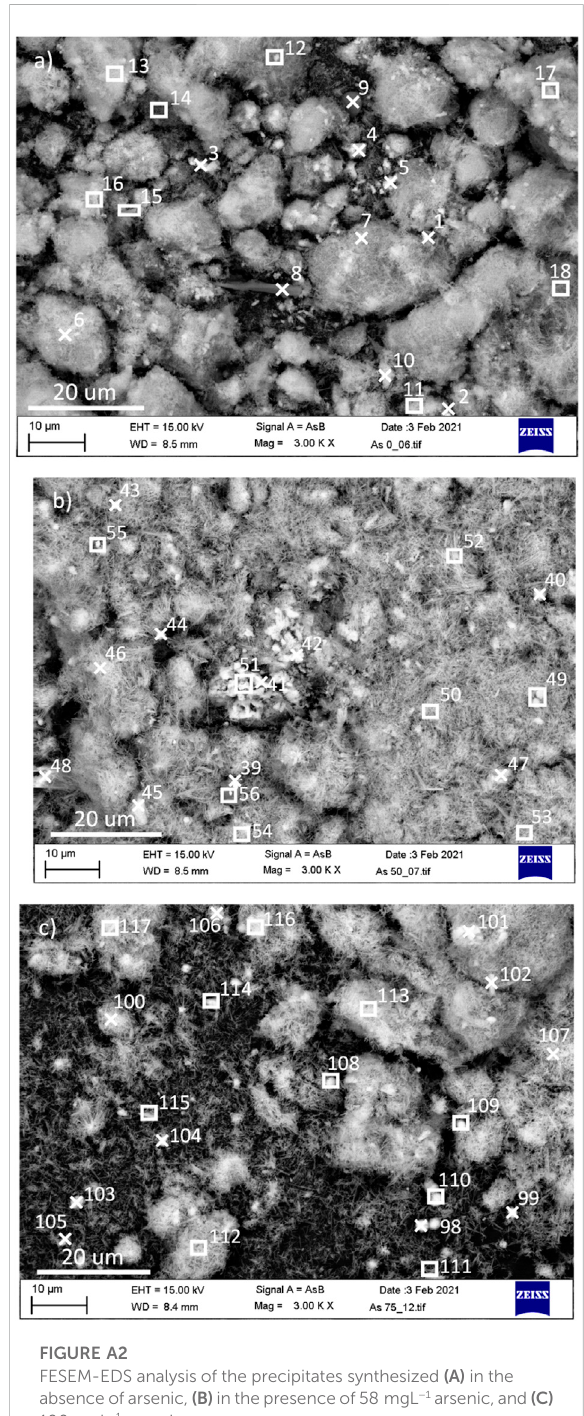
FIGURE A2 FESEM-EDS analysis of the precipitates synthesized (A) in the absenceofarsenic, (B) inthepresenceof58 mgL − 1 arsenic,and (C) 100 mgL − 1